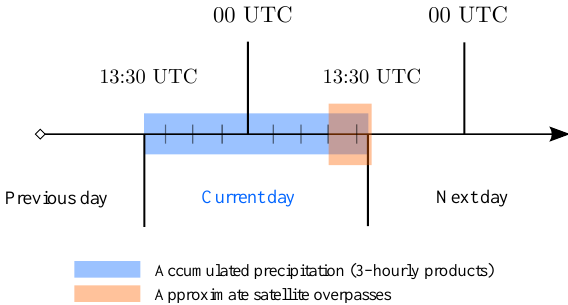
Figure 1. Schematic of the 24h time period selected for the inte- gration of precipitation data. The eight 3-hourly precipitation rates prior to the overpass times of the SCIAMACHY, GOME-2 and OMI satellite sensors are